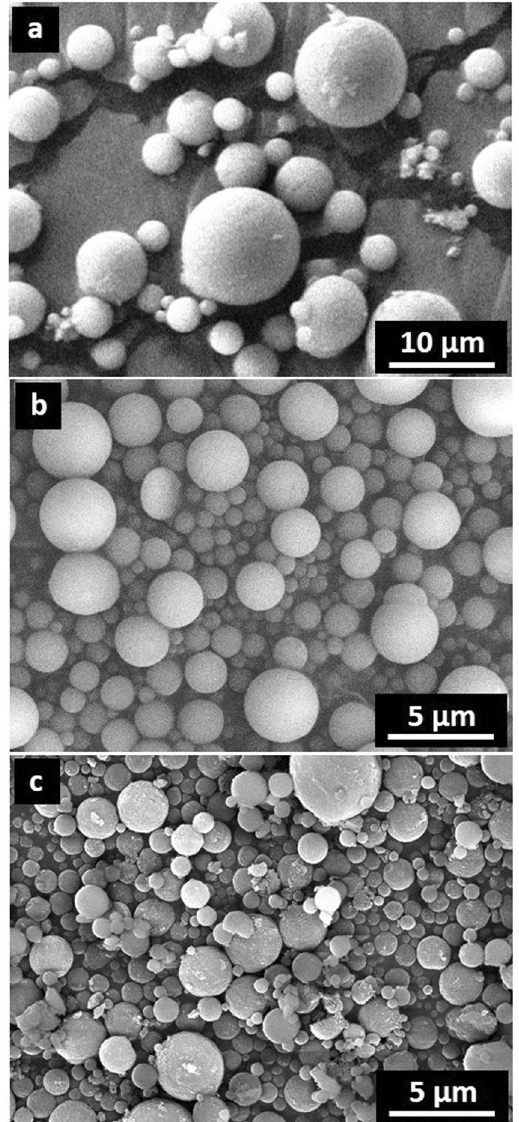
Figure 1. FE-SEM images of PtNP@PDSP-5 produced with air flow rates for atomization during spray-drying of ( a ) 246, ( b ) 473, and ( c ) 670 L h − 1